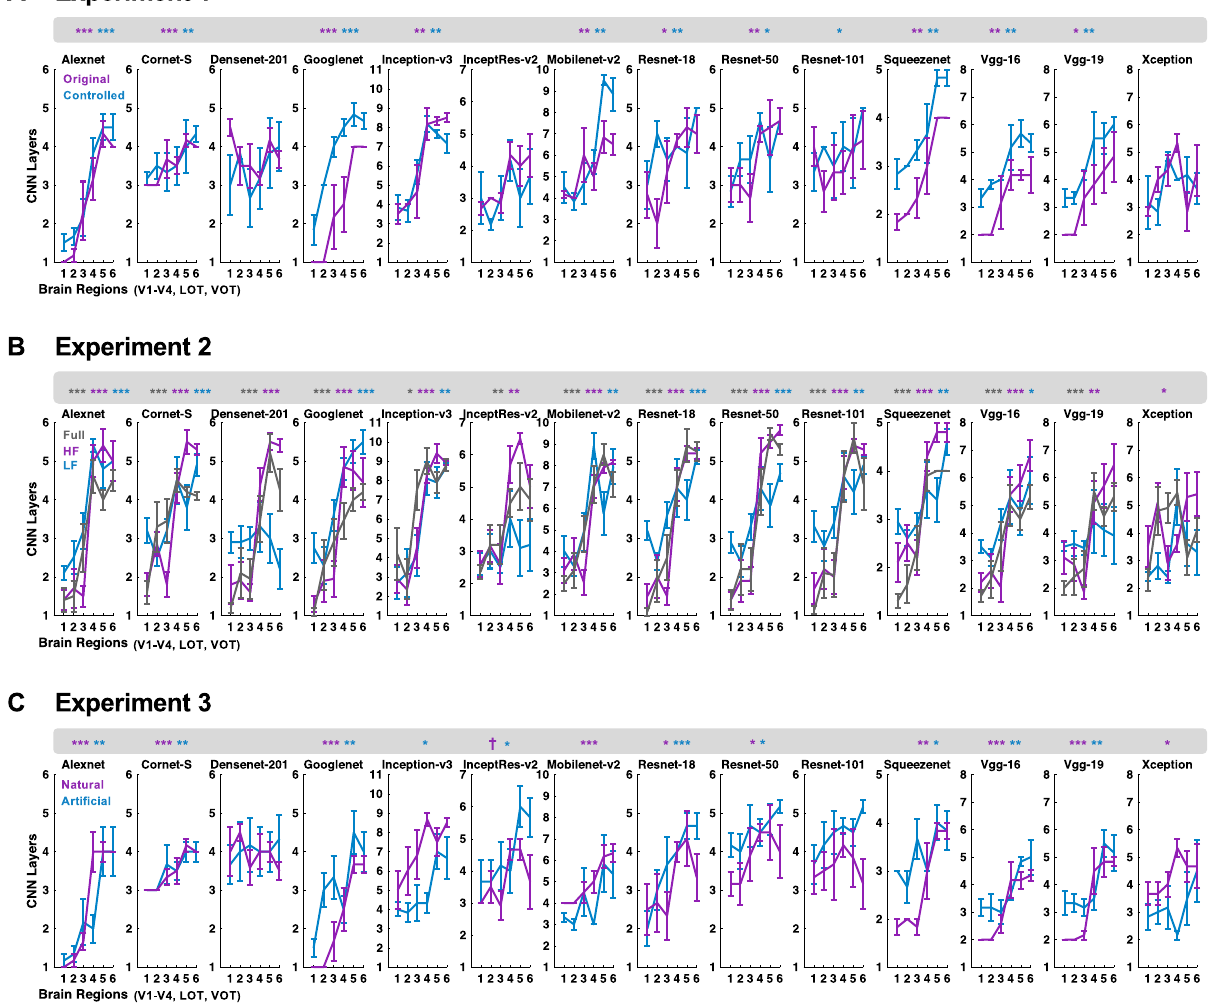
Fig. 2 Evaluation of brain – CNN correspondence in representational structures. A The results from Experiment 1, in which original and controlled images from real-world object categories were shown. N = 6 human participants. B The results from Experiment 2, in which full, high and low SF components of the images from real-world object categories were shown. N = 10 human participants. C The results from Experiment 3, in which unaltered images from both real-world (natural) and arti fi cial object categories were shown. N = 6 human participants. Plotting here are the averaged CNN layer numbers across the human participants that showed the greatest RDM correlation for each brain region in each experimental condition, with the error bars indicating the standard errors of the mean across participants. To evaluate brain – CNN correspondence, in each human participant, the CNN layer that showed the highest RDM correlation with each of the six brain regions was identi fi ed. A Spearman rank correlation was carried out for each participant to assess whether the resulting layer numbers increased from low to high human visual regions. The resulting correlation coef fi cients (Fisher-transformed) were tested for greater than zero at the participant group level using one-tailed t tests. The asterisks at the top of each plot mark the signi fi cance level of these statistical tests, with a signi fi cant result indicating that the RDMs from lower CNN layers better correlated with those of lower than higher visual regions and the reverse is true for higher CNN layers. All t -tests were corrected for multiple comparisons for the number of image conditions included in each experiment using the Benjamini – Hochberg procedure. † p < 0.1, * p < 0.05, ** p < 0.01, *** p < 0.001. Source data are provided as a Source Data fi